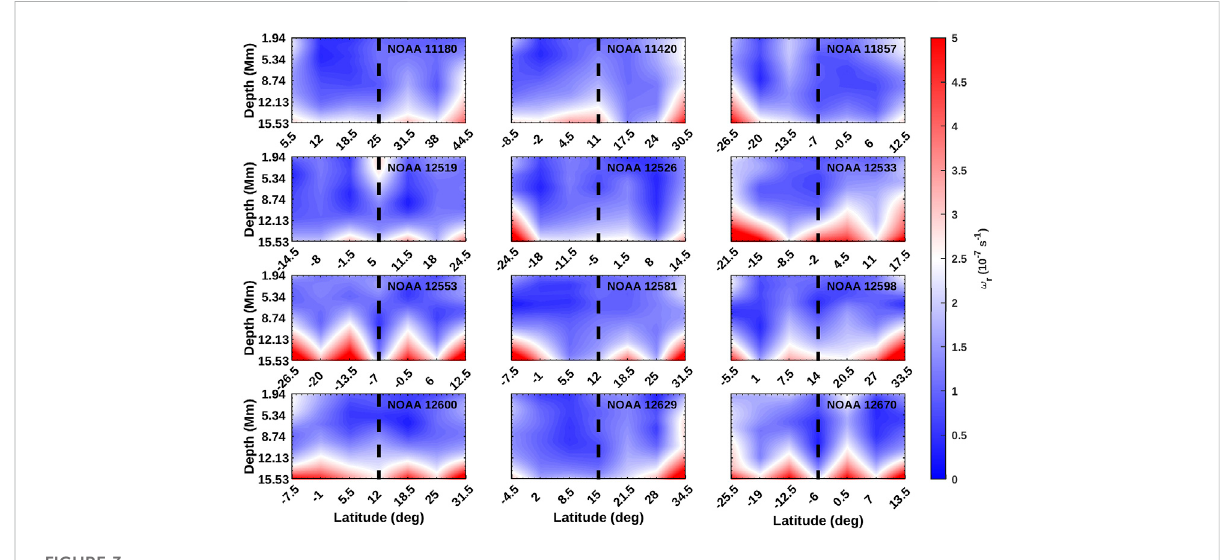
FIGURE 3 Same as Figure 2 but for 12 non- fl aring active